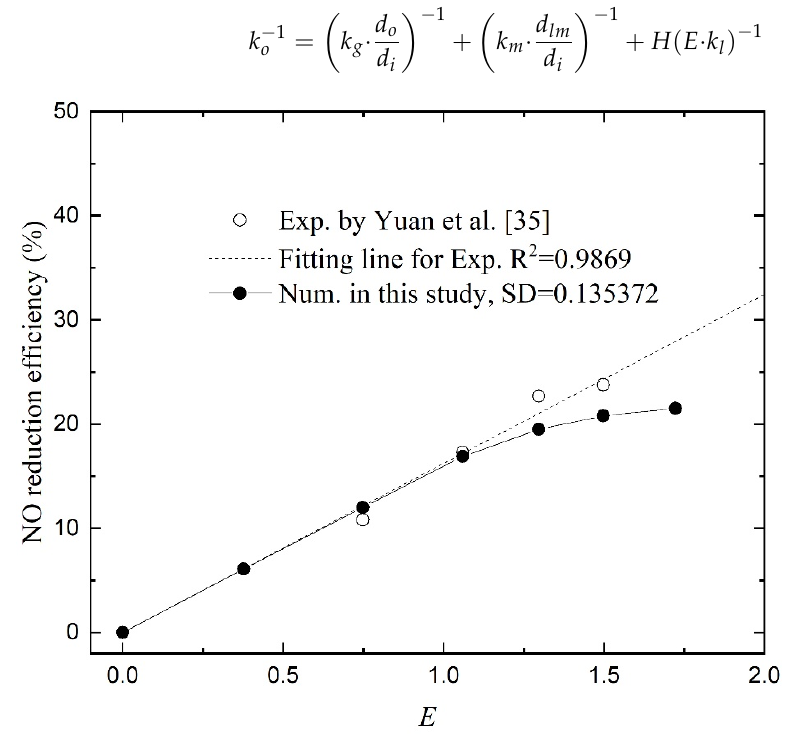
Figure 6. NO reduction as a function of the enhancement factor.